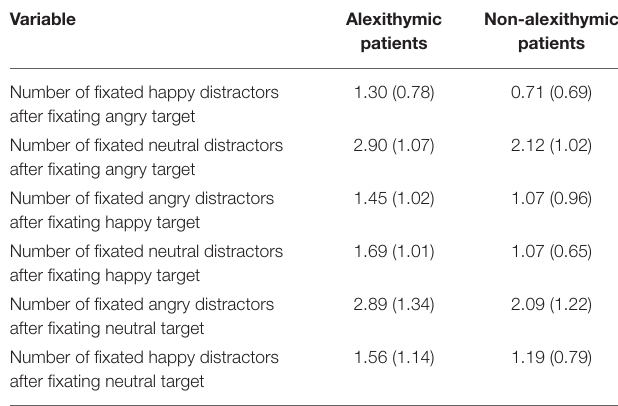
TABLE 5 | Fixation of distractor faces (number of faces) after target fixation as a function of alexithymia and emotional quality of target and distractor face [means and SD (in